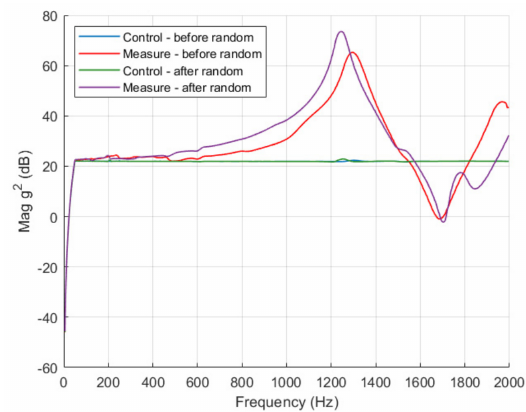
Figure 12. Resonances before and after tests on x axis, AISI 316